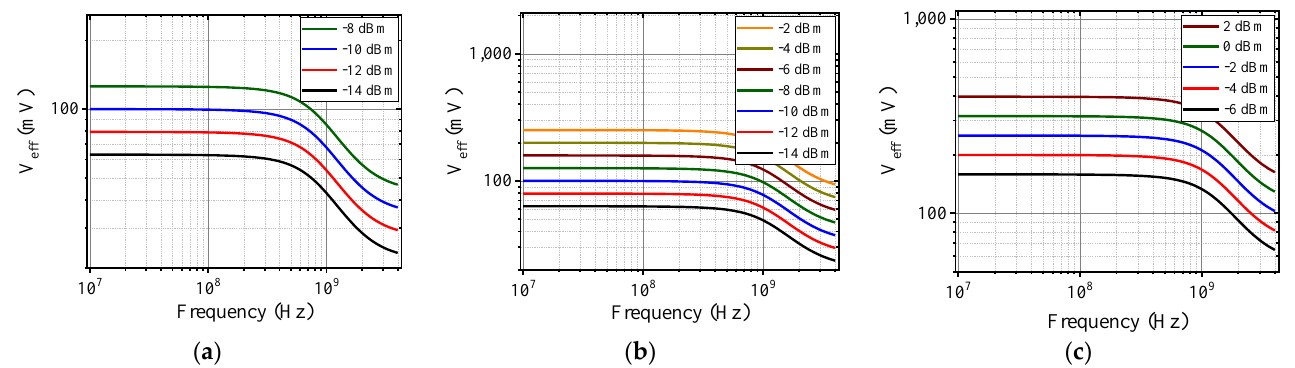
Figure 10. Calculated Veff for NMOS in the inverter ( a ) 65nm, ( b ) 130 nm, and ( c ) 180 nm technology node.